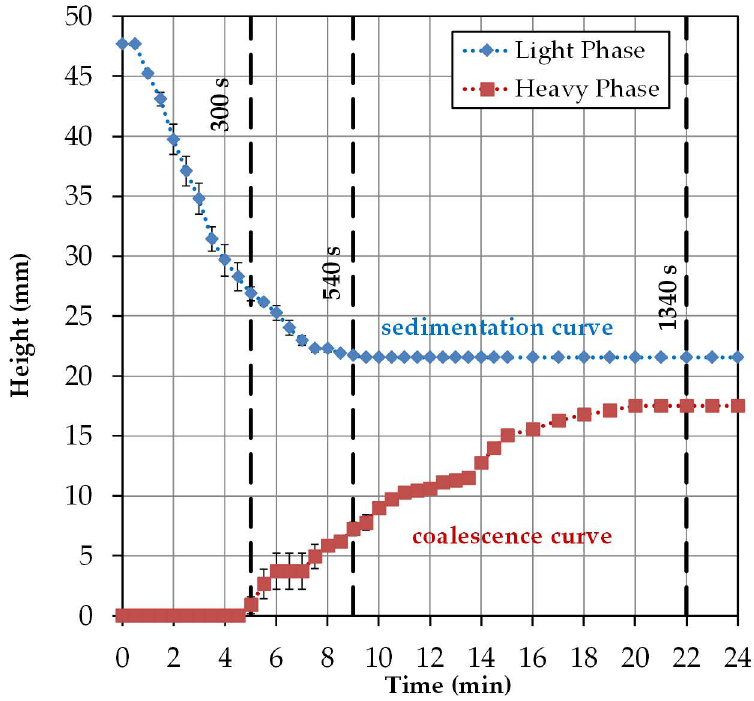
Figure 6. Settling curves obtained by triplicate batch-settling experiments.